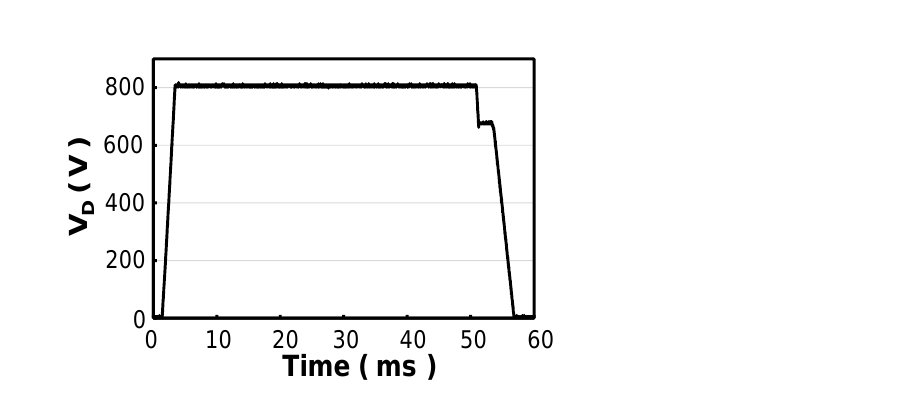
Figure 4. Drain voltage waveform of the GaN HEMTs with the gate protection circuit (Figure 2) immersed in the electronic liquid, Fluorinert (FC-770), under an 800 V, 50 ms single pulse at 175 °C.